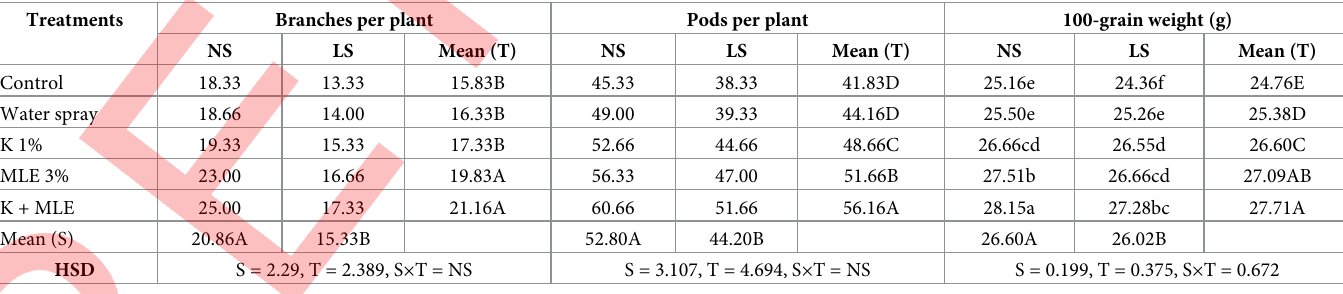
Table 4. Impact of foliar applied potassium and moringa leaf extract on number of branches per plant, number of pods per plant, and 100-grain weight of normal and late sown kabuli chickpea.